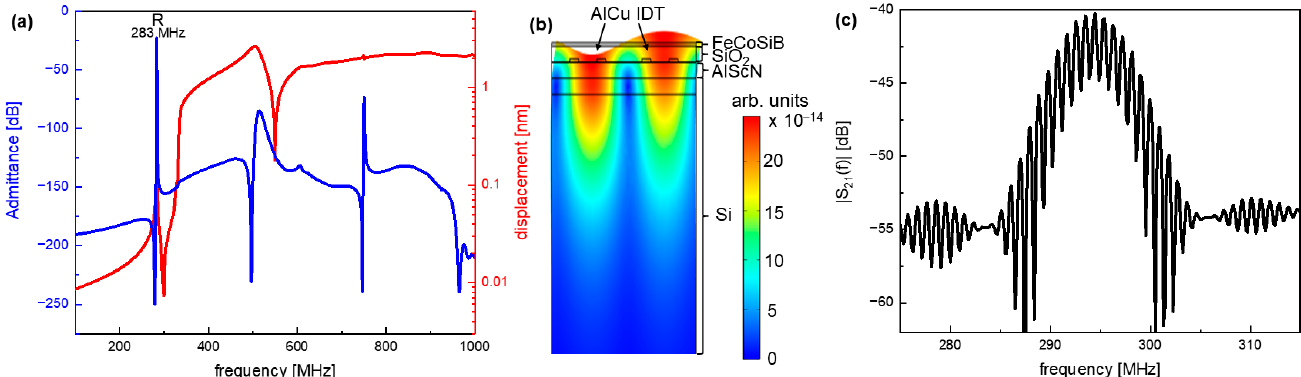
Figure 4. ( a ) FEM-simulated displacement (red) and admittance (blue) for the presented sensor design. ( b ) Colored map of absolute deflection for the Rayleigh-like mode at 283 MHz. The deflection into the FeCoSiB layer, the SiO 2 intermediate layer, the IDTs, the AlScN layer, and the Si substrate are displayed. ( c ) Measured transmission behavior (scattering parameter S 21 ) of the presented sensor. The synchronous frequency of the sensor is determined to be 294.2 MHz with a return loss of 40 dB.